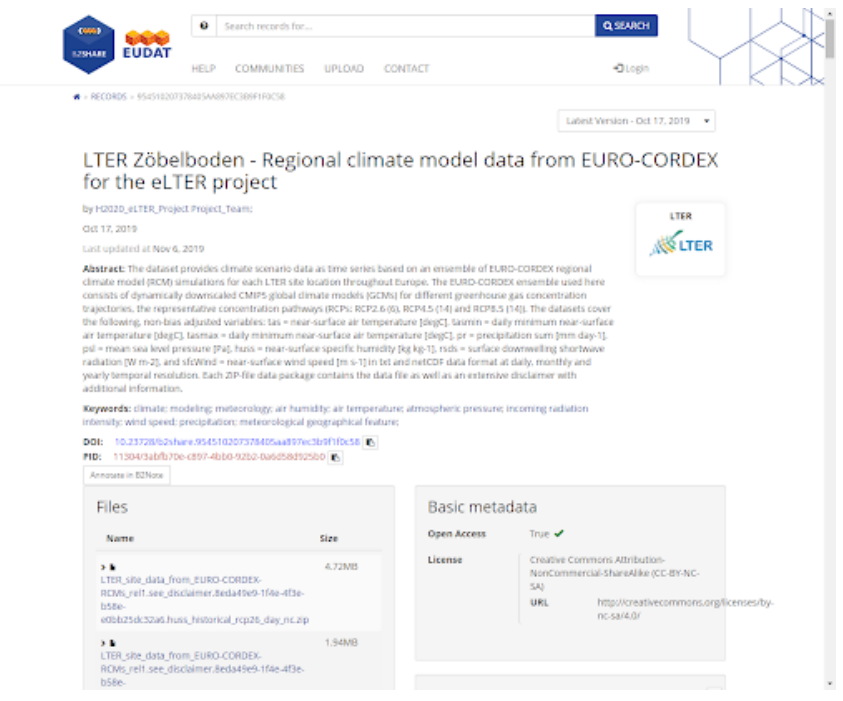
Figure 4. B2SHARE